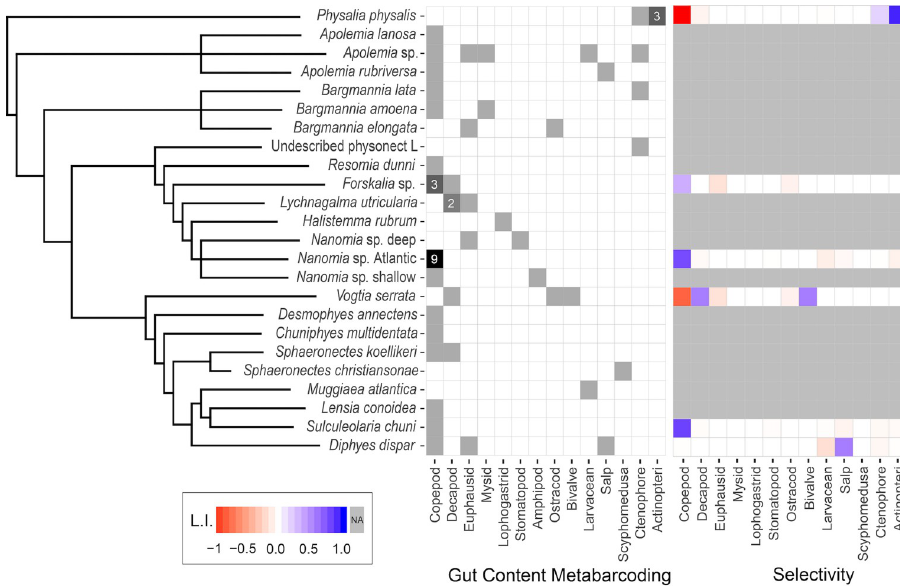
Fig 4. Species-wise grid with the frequency of the major prey types identified from the metabarcoding data and the average prey-type selectivity. Gut content cells in white indicate absence, and cells in grey indicate presence in one specimen, or more than one specimen if labeled with a number. Selectivity colors mapped to Strauss’ L.I. values. The siphonophore cladogram (left) is a simplified version of the phylogenetic tree published in Damian-Serrano et al.